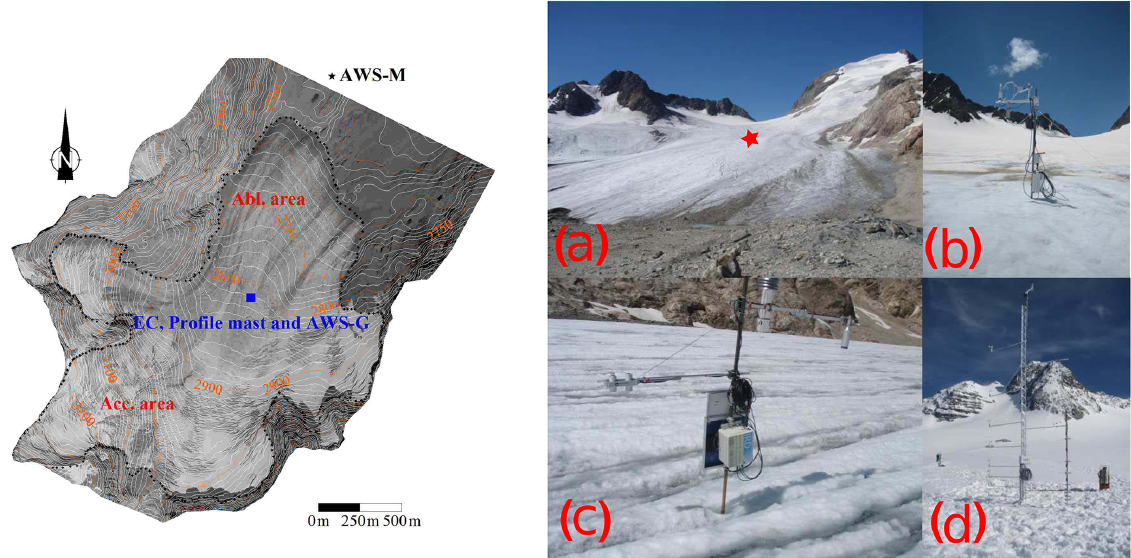
Figure 1. Overview of the glacier and the instruments installed during the field campaigns. Left: topographic map of the glacier and position of the instruments. (a) Picture of the Saint-Sorlin Glacier taken from the AWS-M (heading to the top of the glacier, south is at the horizon); (b, c, d) the instruments installed during the 2006 and 2009